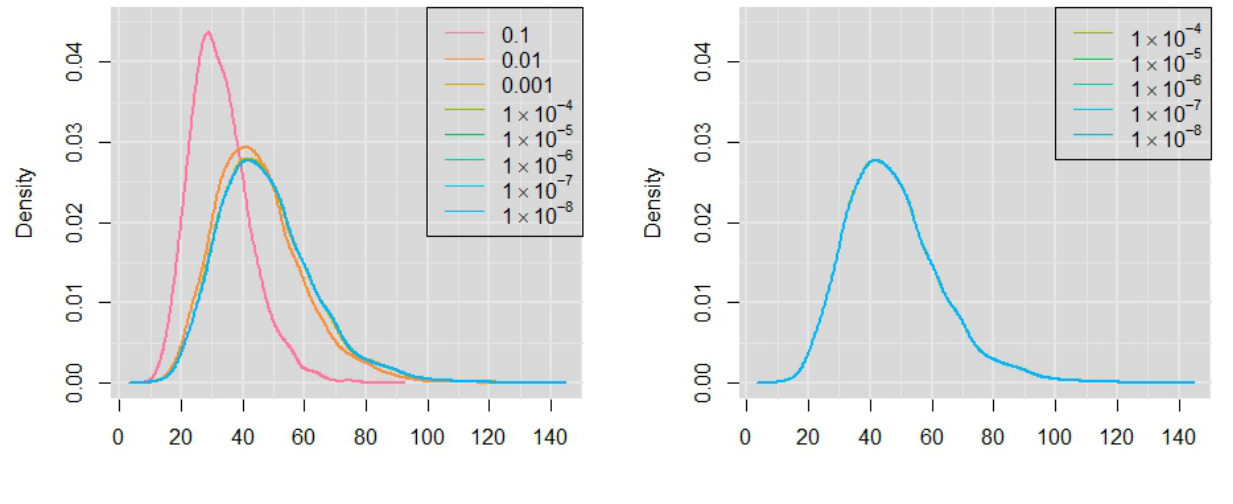
Figure 4. Posterior marginal distributions for the precision parameter ψ = 1/ τ , the inverse of the variance parameter τ for the random effects, for different values of α , where ψ ∼ G ( α , α )